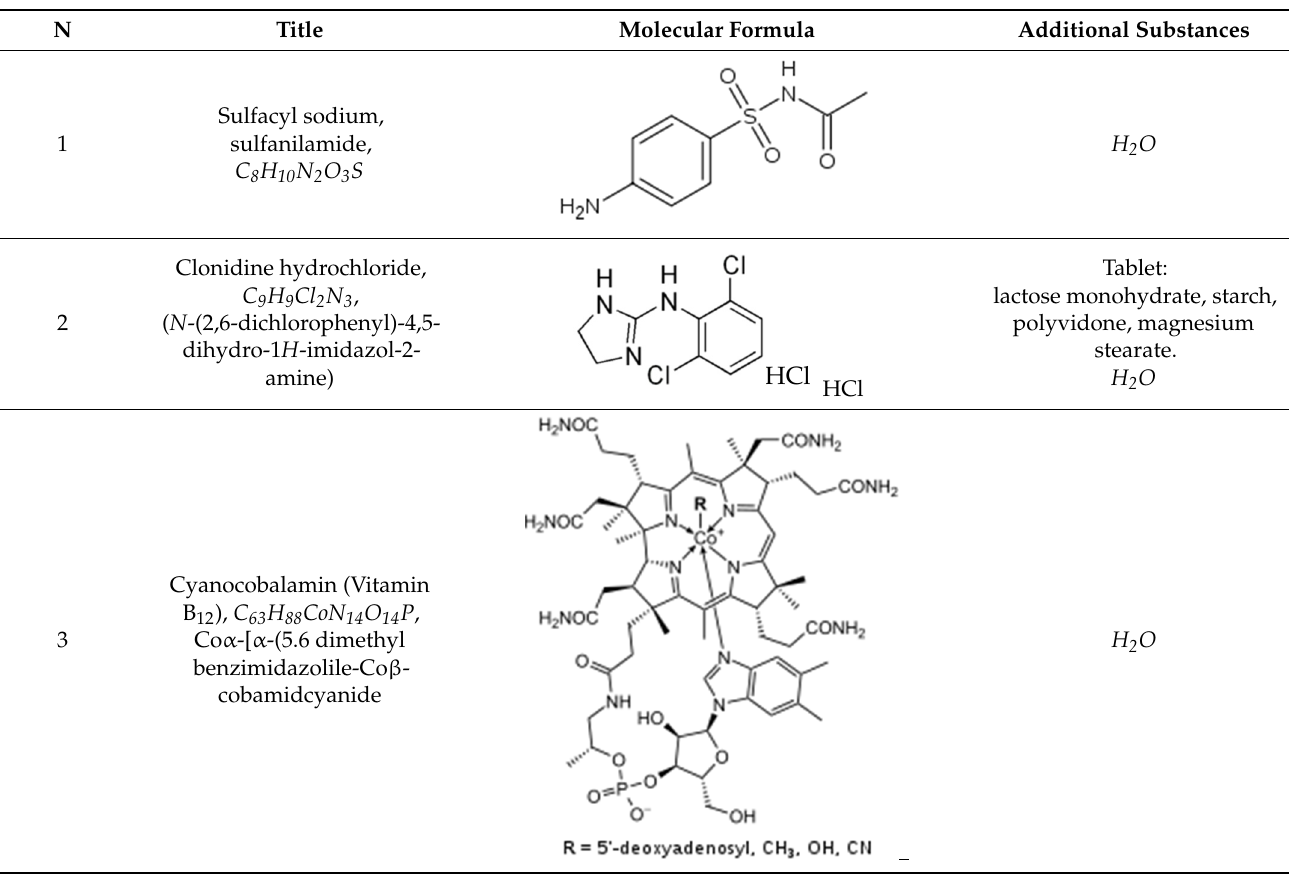
Table 1. Pharmaceutical materials, their abbreviations, chemical compositions, molecular formulas, and additional substances [26].